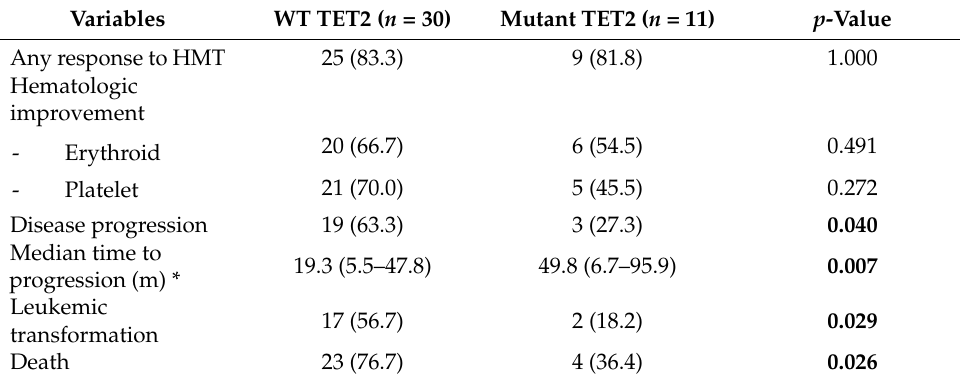
Table 2. Treatment outcomes of HMT according to TET2 mutation